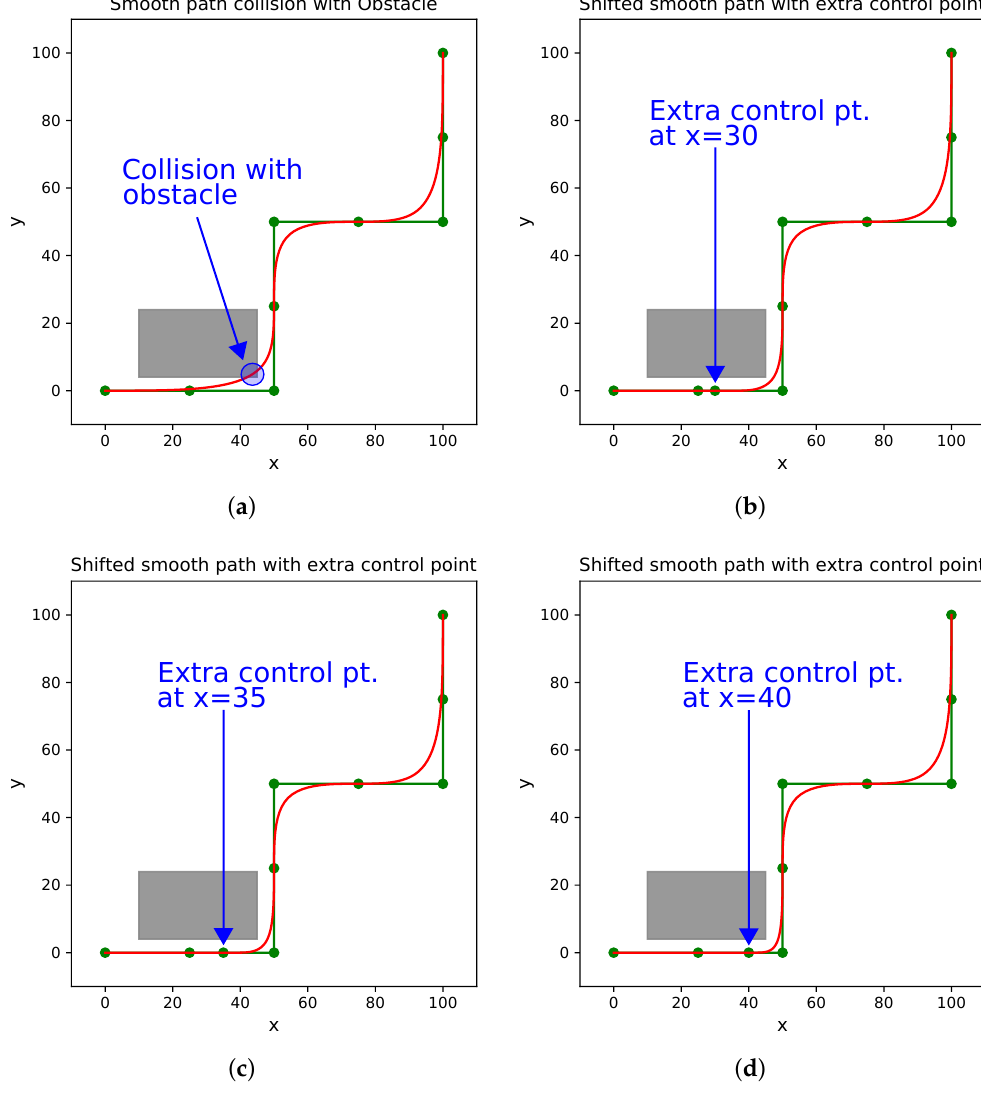
Figure 10. Problem of smooth trajectory generation while avoiding collision with obstacles with the case of B-Spline-based smoothing. ( a ) Smooth path in red color collides with the obstacle. ( b ) Inclusion of extra control point at x = 30 avoids collision. ( c ) Smooth path with extra control point at x = 35. ( d ) Smooth path with extra control point at x =